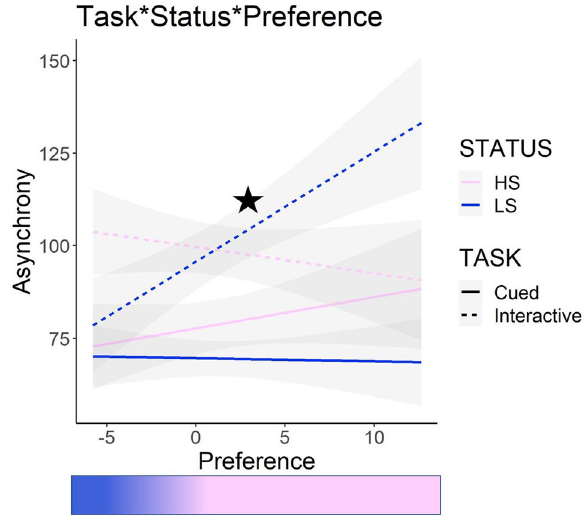
Figure 6. Grasping Asynchrony with the high- and low-status confederates during the Interactive task was modulated by participants’ implicit preference. Positive values of Preference (right side of the x axis) indicate a preference for the high-status, while negative (left side of the x axis) values indicate a preference for the low-status. Smaller values of Asynchrony indicate a better performance. A star indicates a simple slope that is significantly different from zero (i.e., the 95% confidence interval does not contain